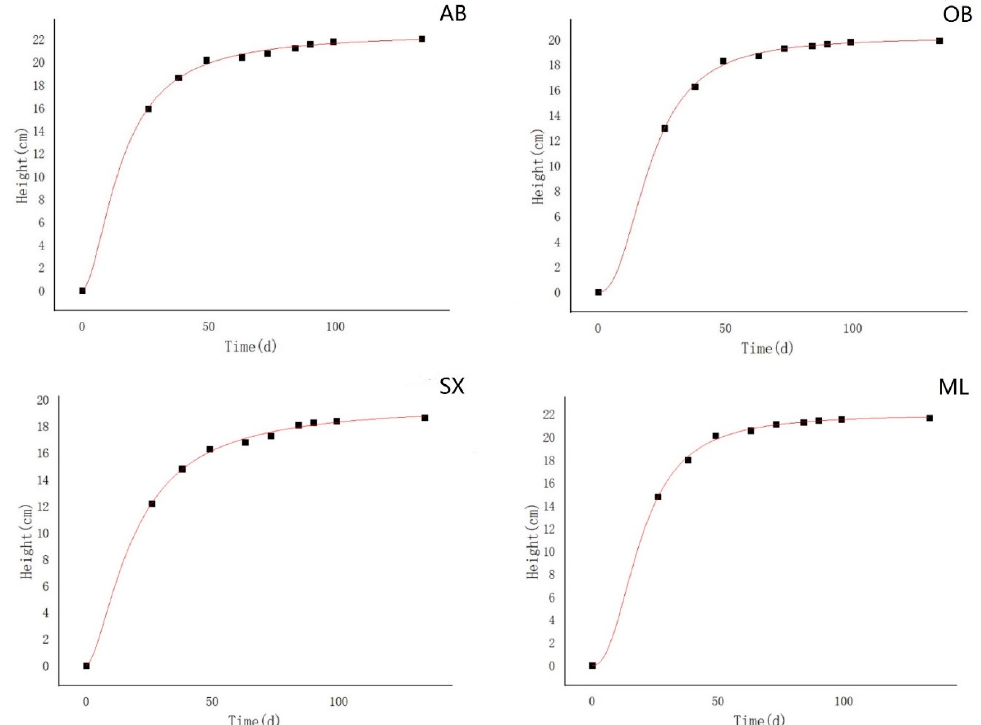
Figure 5. Logistic fitting curves of seedling height of X. sorbifolium from different provenances. AB—